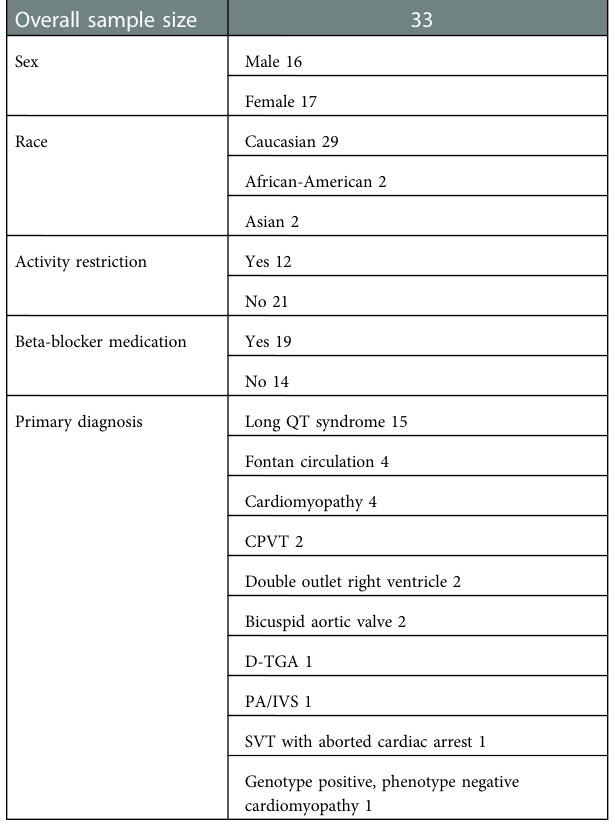
TABLE 2 Results of serial testing of anthropometric data as measured by bioimpedance analysis and cardiopulmonary exercise testing in 33 pediatric and congenital heart disease patients before and during the COVID-19